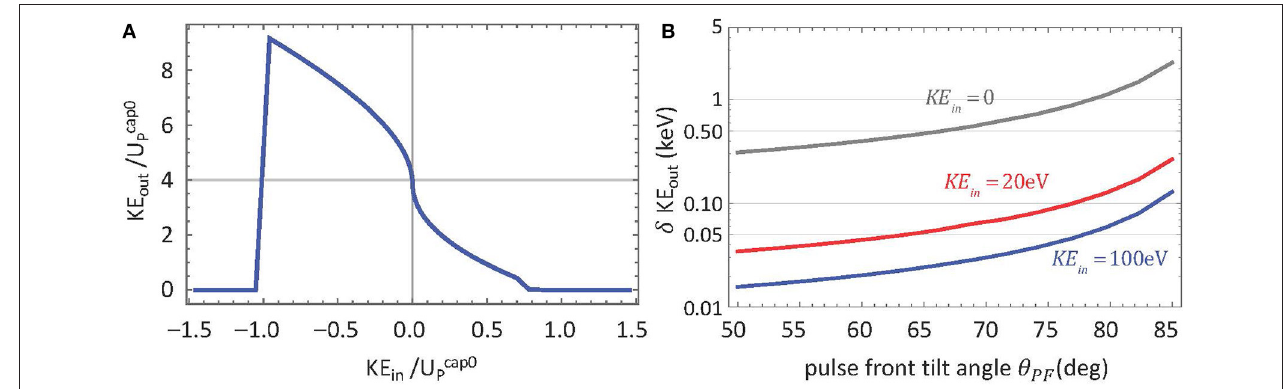
FIGURE 4 | (A) Output kinetic energy KE out as a function of the seed electron kinetic energy KE in for U P 0 = 500 keV . Both energies are calculated relative to the zero initial velocity capture potential. Negative KE in corresponds to electron velocity that is initially heading toward the beam. (B) Relative variation in the output kinetic energy as a function of PFT angle for three values of the co-moving seed kinetic energy. The test value of δ KE in is 1 eV.